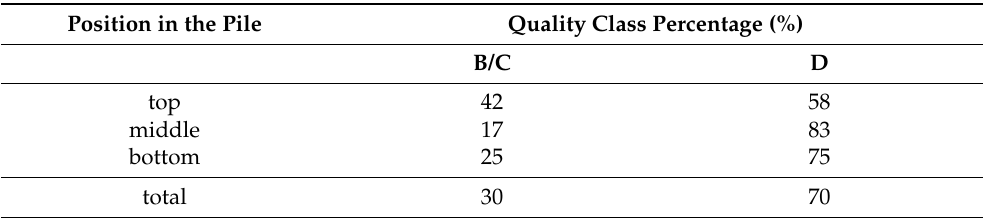
Table 1. Allocation of the assessed log sections from the prematurely terminated piles no. 5 and 9, separated according to their position in the